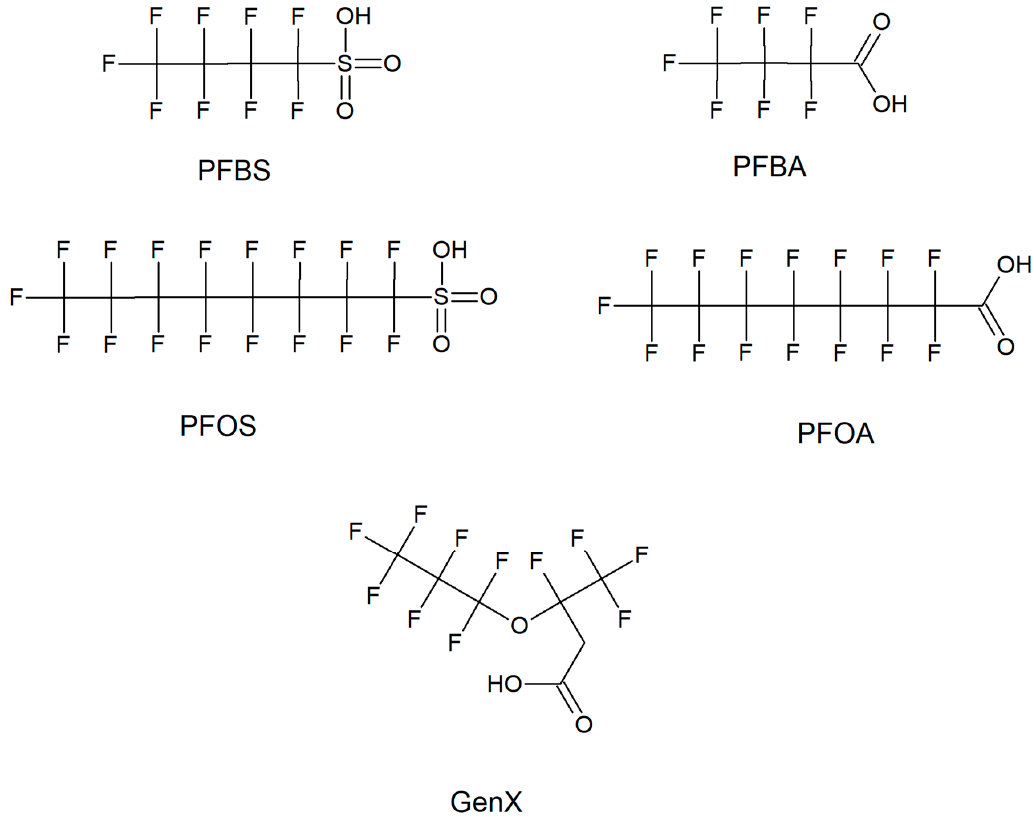
Figure 1. Structures of the representative per- and polyfluoroalkyl substances (PFAS) discussed in this